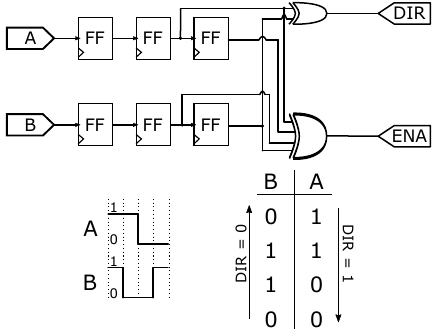
Figure 10. Encoder module